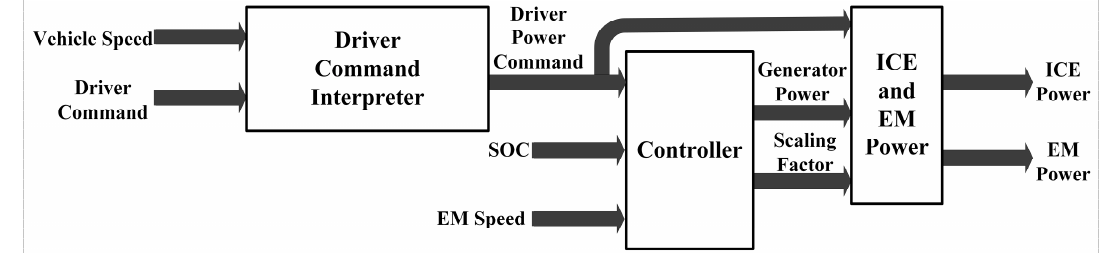
Figure 5. Example of energy management strategy used in HEV. The controller splits power between the ICE and the motor by considering different input parameters. Adapted from [8].